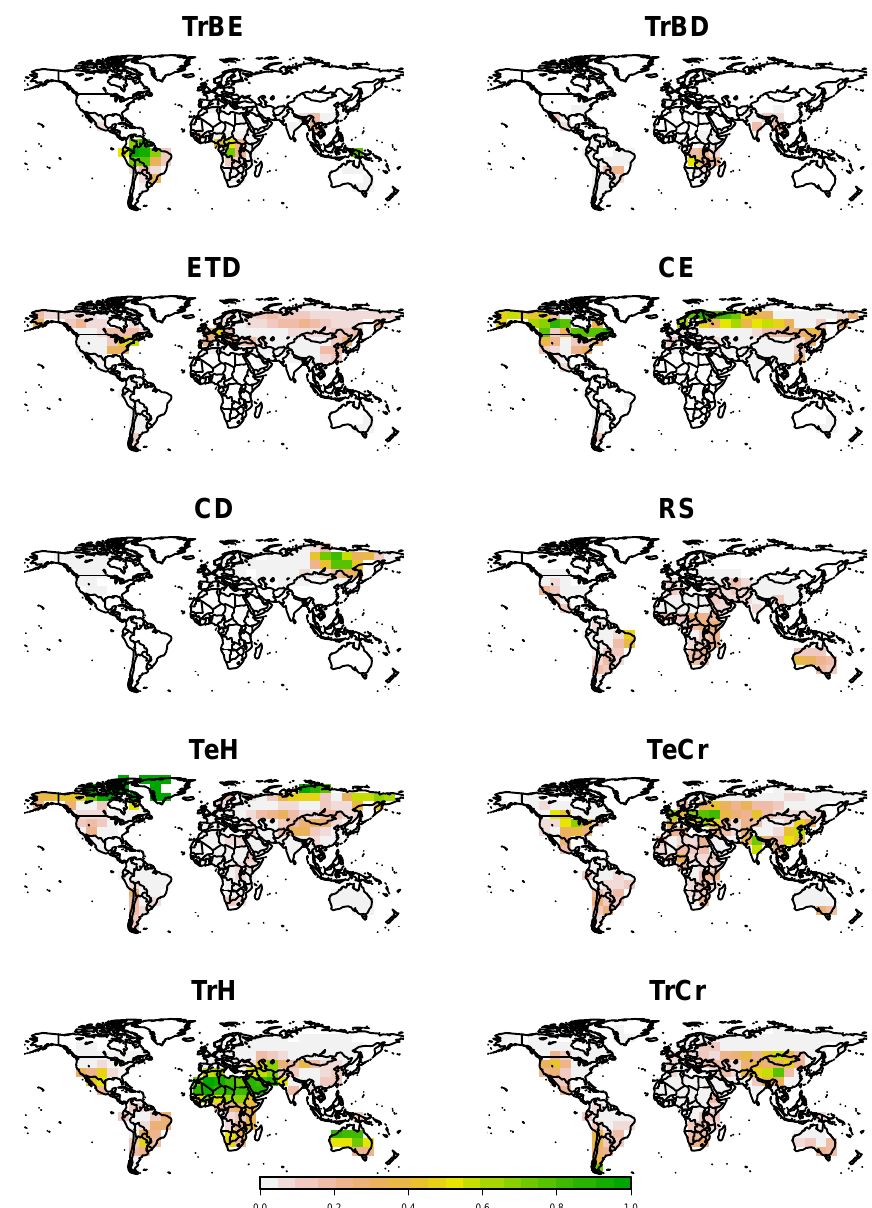
Figure E1. Fractional vegetation coverage of the PFTs as prescribed in the MPI-CCDAS. See Table 1 for abbreviations.